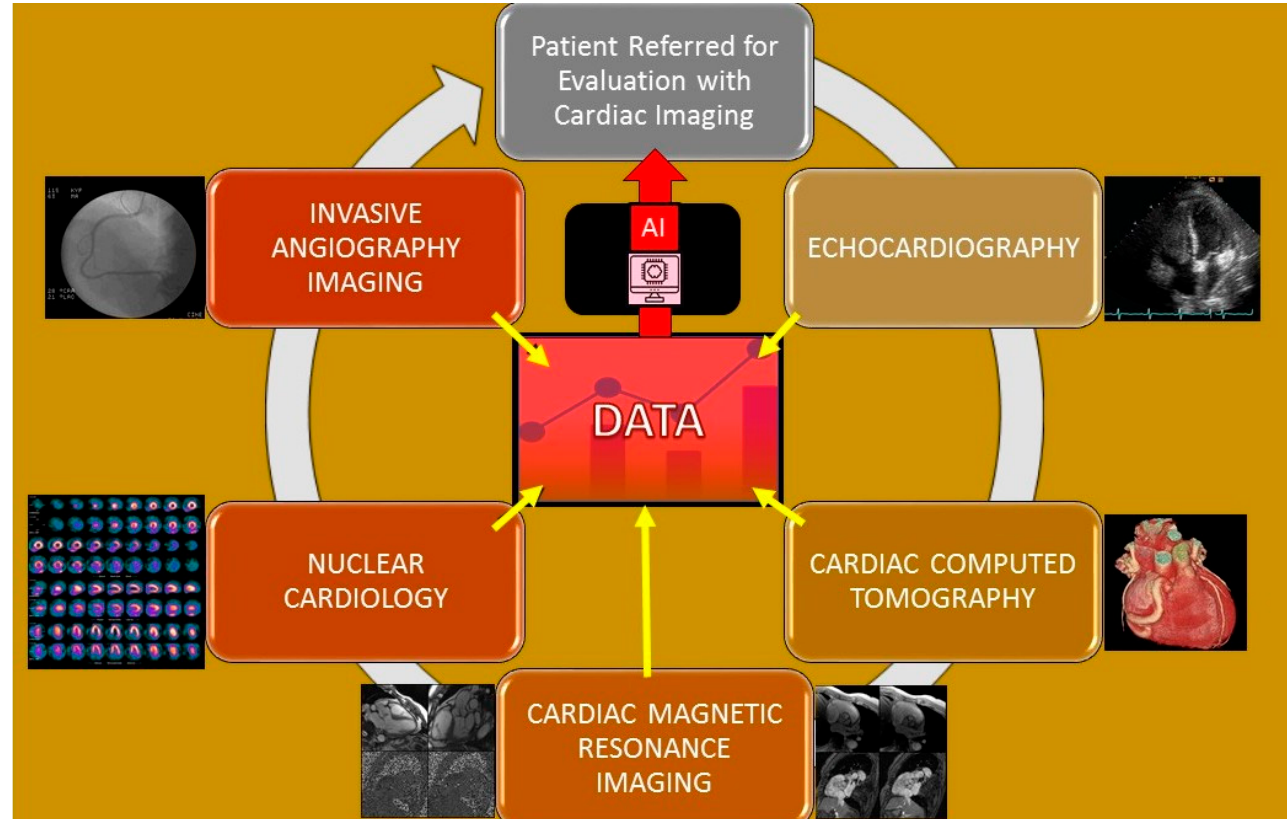
Table 2. Pertinent publications regarding artificial intelligence.